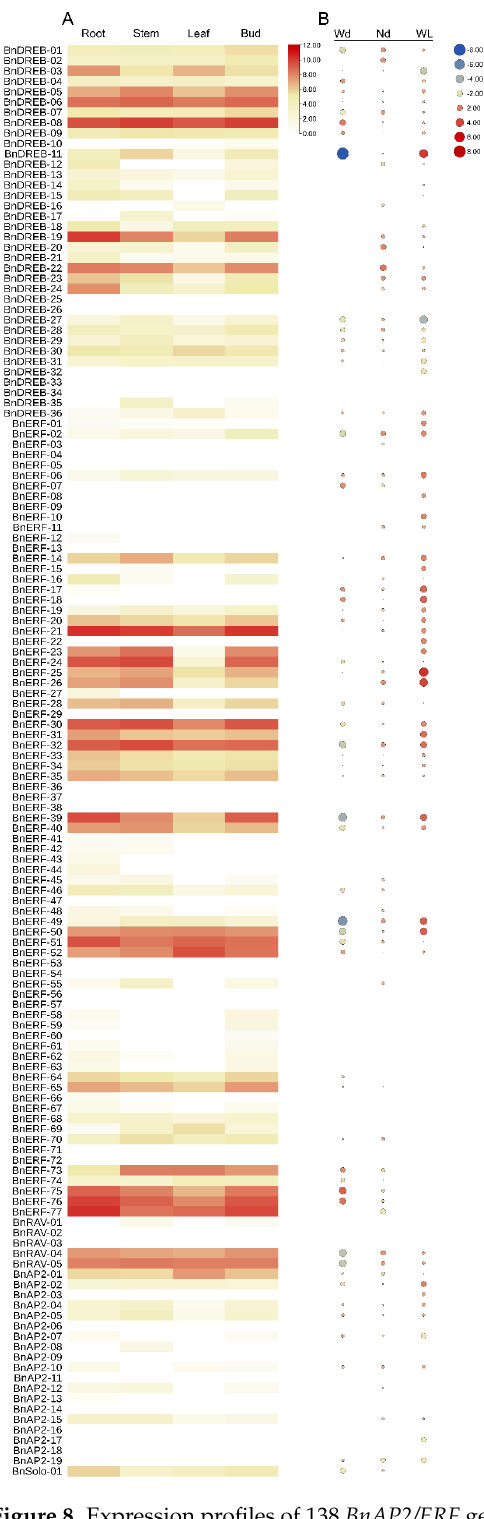
Figure 8. Expression profiles of 138 BnAP2/ERF genes based on RNA-seq data: ( A ) The heat map of the expression profiles of BnAP2/ERF in four different tissues, which was generated using TBtools software based on log 2 (FPKM + 1) conversion counts of RNA-seq data. Red and white boxes indicate high and low expression levels of BnAP2/ERFs , respectively. ( B ) The heat map of the relative expression (converted by log 2 FC values) of BnAP2/ERF under water deficit (Wd), nitrogen deficit (Nd), and waterlogging (WL), with up-regulated genes marked in red and down-regulated genes marked in blue.